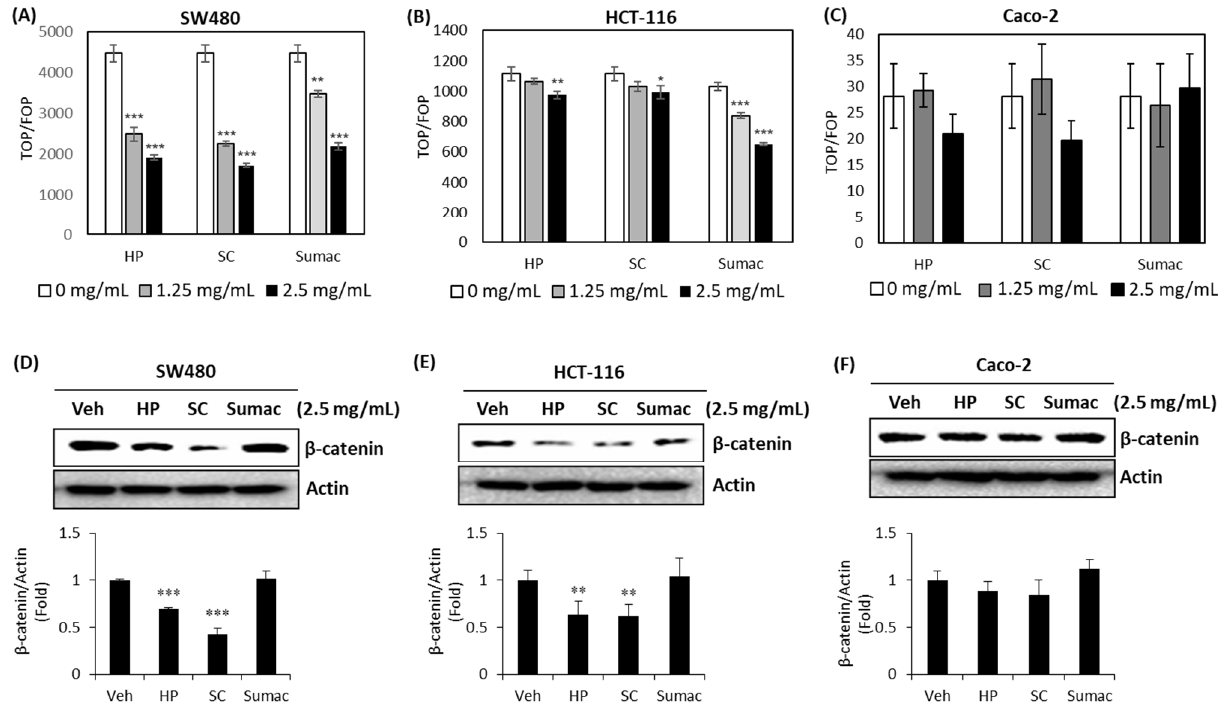
Figure 3. High phenolic sorghum bran extracts downregulate β -catenin expression and its transcriptional activity in human colon cancer cells. ( A – C ) Three human colon cancer cells, SW480 ( A ), HCT-116 ( B ) and Caco-2 ( C ) cells were transfected with TOP or FOP with pRL null luciferase plasmid for 48 h and then treated with 0, 1.25 and 2.5 mg/mL of sorghum bran extracts for 24 h. Luciferase was assayed using Dual Luciferase Assay System (Promega). ( D – F ) SW480 ( D ), HCT-116 ( E ) and Caco-2 ( F ) cells were treated with 2.5 mg/mL of sorghum bran extracts (HP, SC and Sumac) for 24 h and Western blotting was performed for β -catenin and actin. Values are the mean ± SD ( n = 3). Significant differences between vehicle- and sorghum bran extract-treated groups are indicated as * p < 0.05, ** p < 0.01, *** p < 0.001.